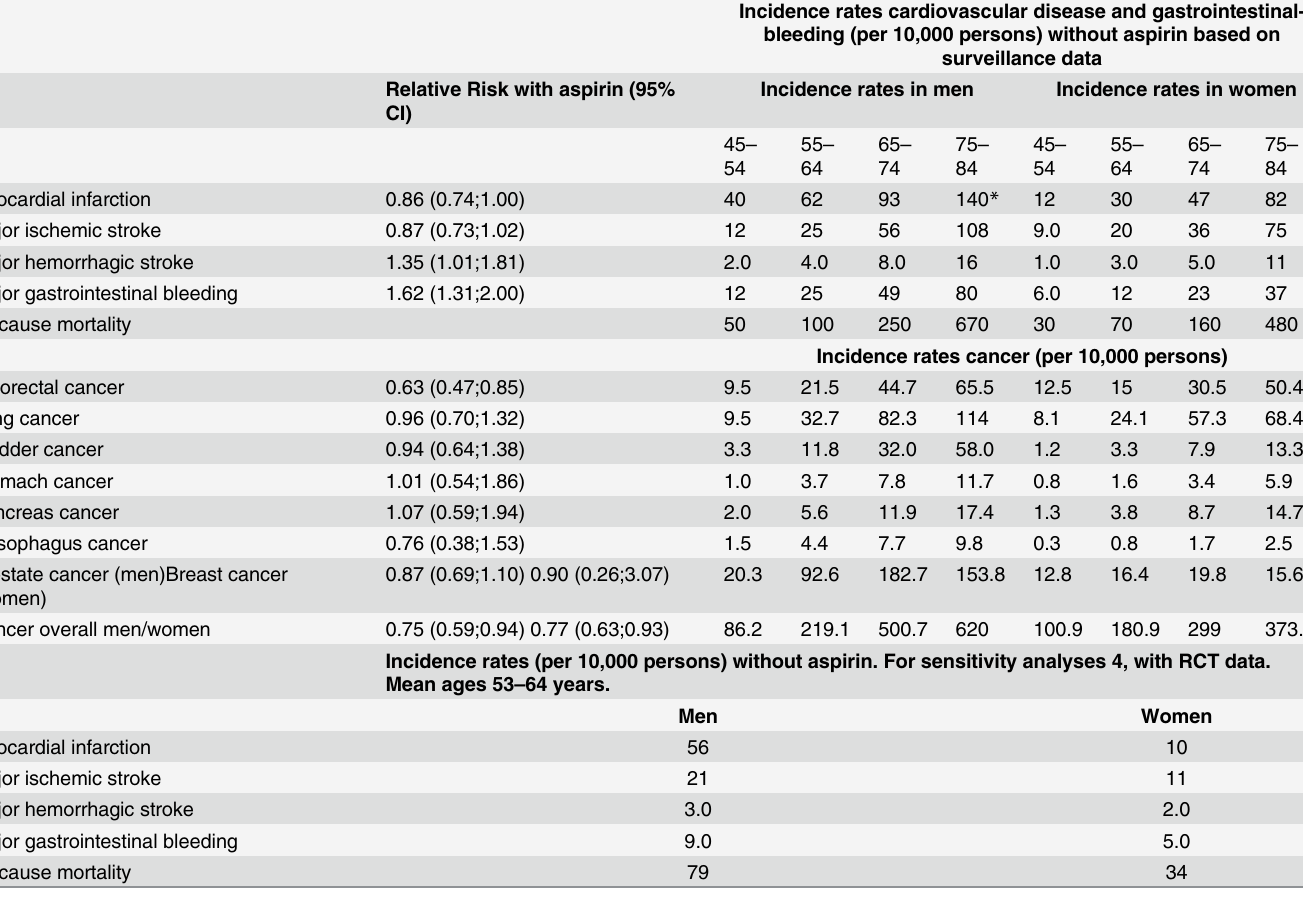
Table 1. Data for benefit-harm assessment. Treatment effects and outcome